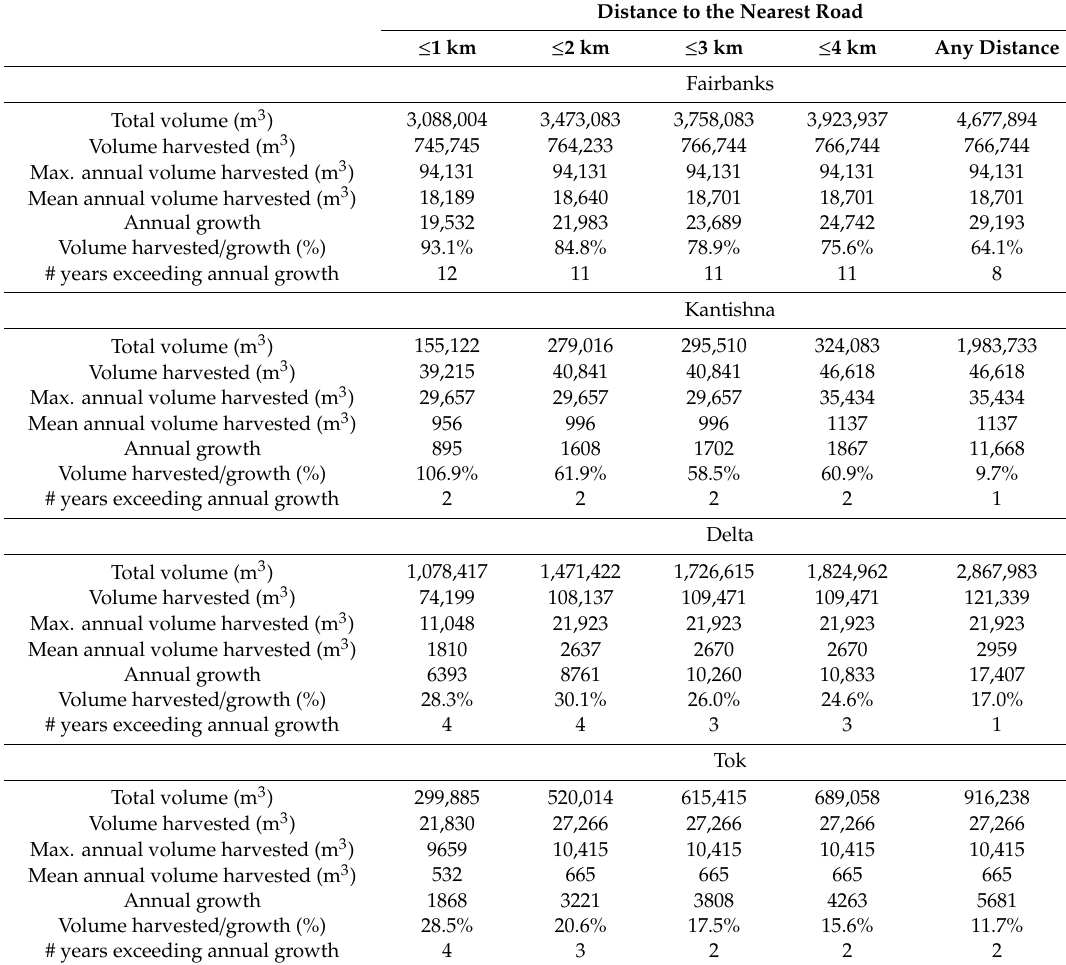
Table 8. Total volume, volume harvested, maximum annual volume harvested, mean annual volume harvested, annual volume harvested divided by annual volume growth, and the number of years exceeding annual volume growth of white spruce sawlogs in each management areas on state forest